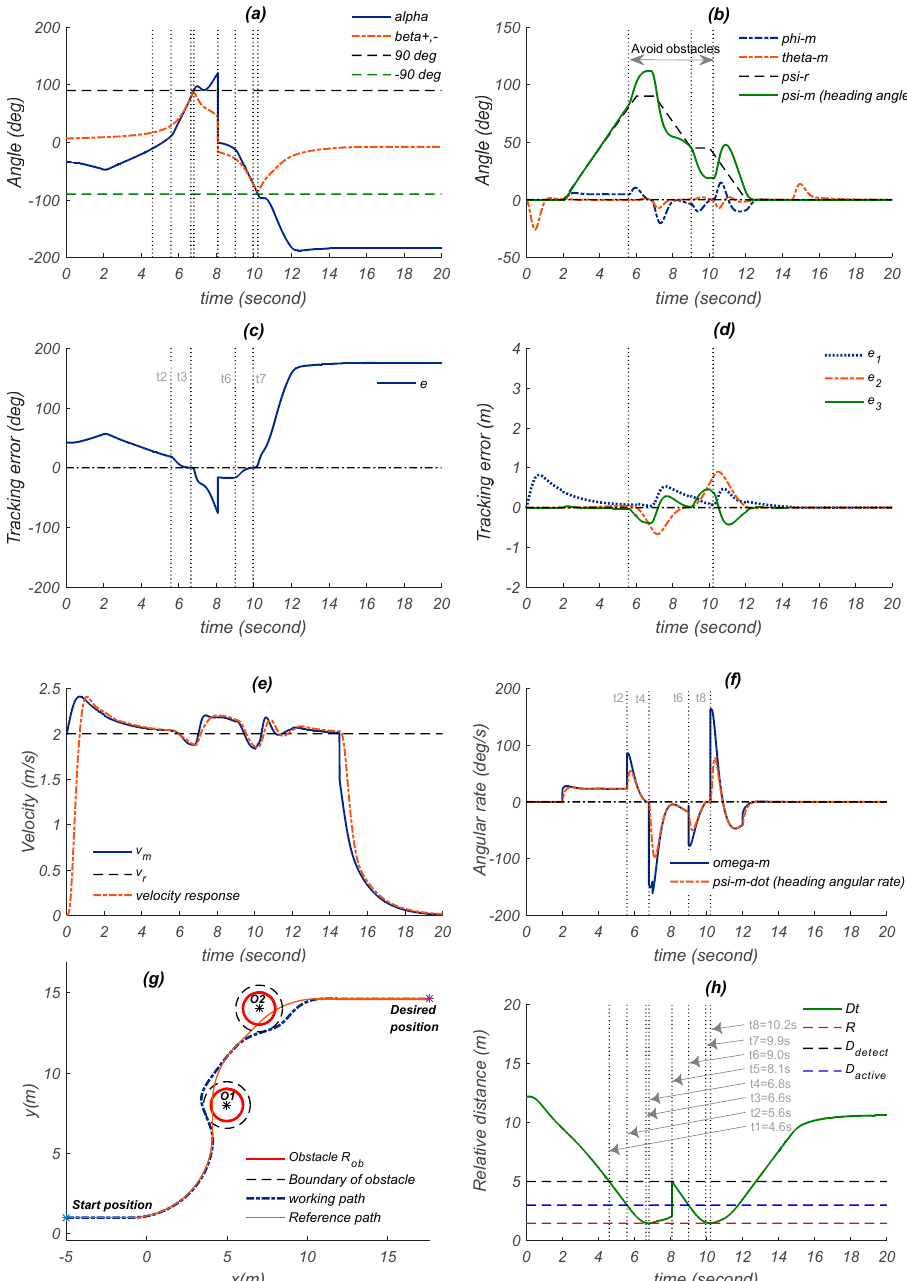
Figure 8. Example 2, the reference path was a spline and an obstacle was placed at O1 (5, 8) and O2 (7, 14): ( a ) Angle α tracking β ± ; ( b ) Attitude performance; ( c ) The angular tracking error e; ( d ) The position tracking error e1, e2, e3; ( e ) The velocity performance of the vehicle; ( f ) Heading angular rate; ( g ) The performance of the working path in 2D; ( h ) The relative distance between the vehicle and the obstacle.